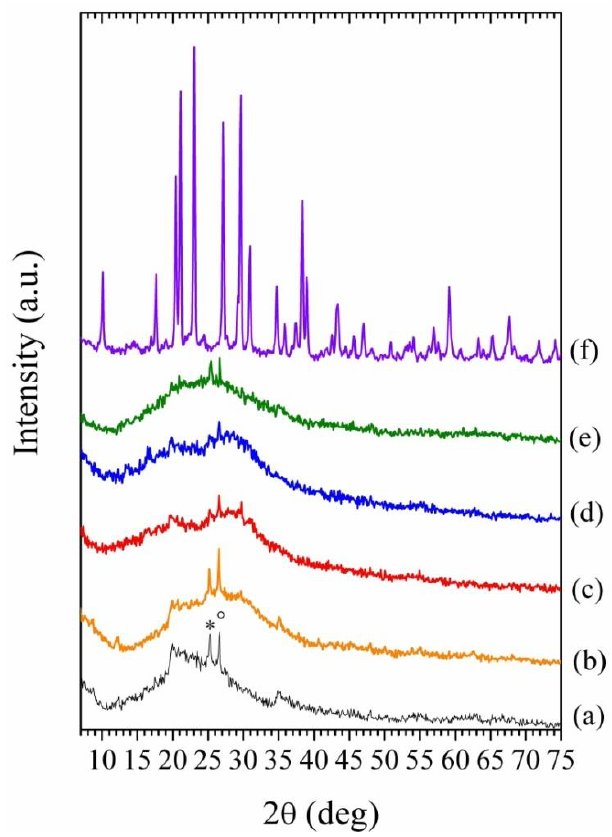
Figure 5. X-ray powder diffraction patterns of (a) metakaolin; (b) Geopolymer; (c) GeoEpojetLV20; (d) GeoEpojet20; (e) GeoEpojet20 after 12 h at 500 °C; and (f) GeoEpojet20 after 24 h at 800 °C. * = anatase; ° = quartz.